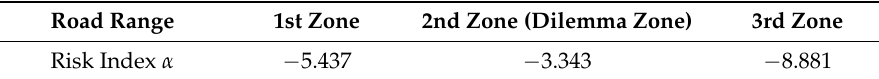
Table 6. Risk index of different parts of